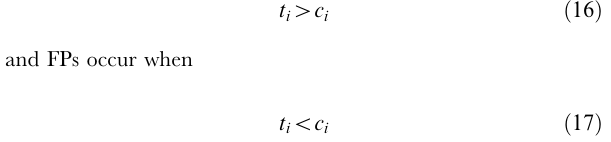
Figure S1 The distribution of prediction errors for Toy B data using SIMA (mass resolution 0.00001 Daltons). The horizontal axis represents the noise rate added to features in Toy B. The vertical axis represents either missing hypothesis (MH) or a false prediction (FP). Each histogram group comprises ten bars representing ten types of consensuses, i.e. consensuses containing ten different features. The first bar represents the error between the number of expected singletons and the number of predicted singletons. The last bar represents the error between the number of true consensuses of size ten and the number of predicted consensuses of size ten. When FP occurs, we will see a positive bar (extending upwards from the horizontal axis). When MH occurs, we observe a negative value (extending downwards from the horizontal axis). Figure S2 Characteristic alignment map (CAM) curves. The CAM was done for MCM analysis of six alignments on the real data of pathogen infected plant leaves. The horizontal axes represent the maps used for each alignment, i.e. from six to 24.